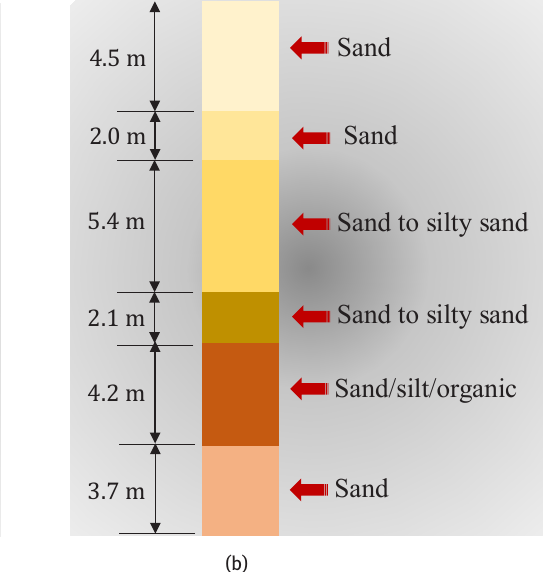
The different bending moment profiles are plotted in Figure 5. With the exception of Kallehave et al.’s model which underestimates the bending moment on almost the entire monopile length, it is clearly seen that all methods exhibit an identical tendency with nearly the same value of maximum bending moment, which differs slightly from that of ABAQUS . This gives a confirmation that the indicator to assess the BNWF model. The profiles of shear forces are shown in Figure 6. With respect to shear forces,